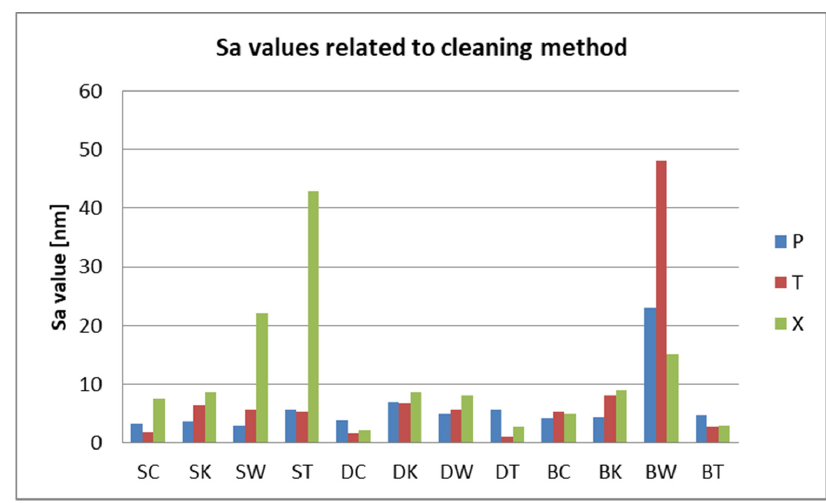
Figure 17. Sa values related to the cleaning method.